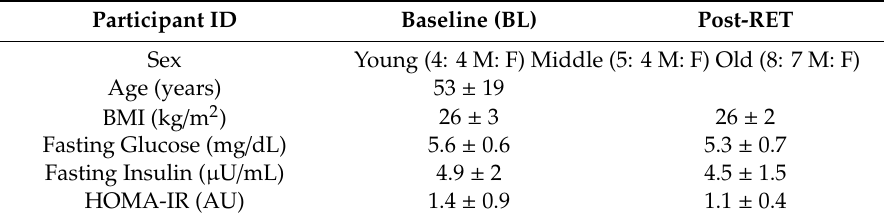
Table 1. Participant demographics M: F denotes n of males to females per group.